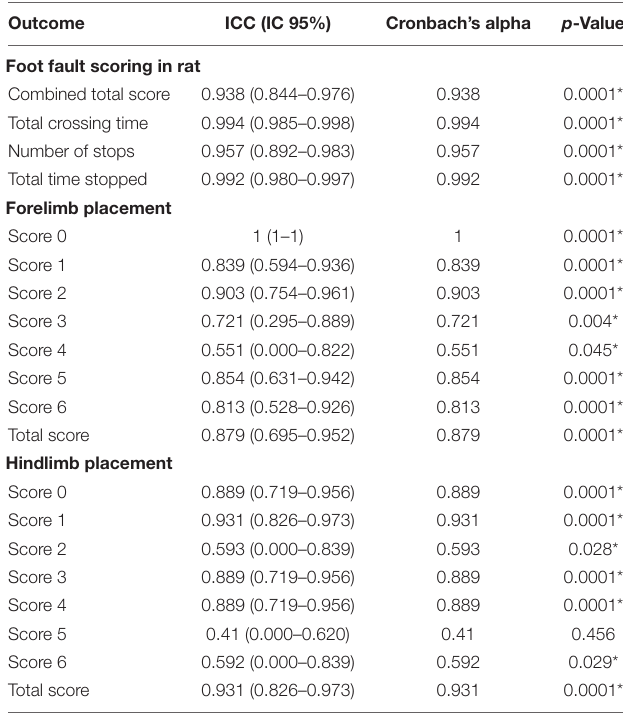
TABLE 2 | Agreement between raters I and II regarding the outcomes obtained in the LRWT in